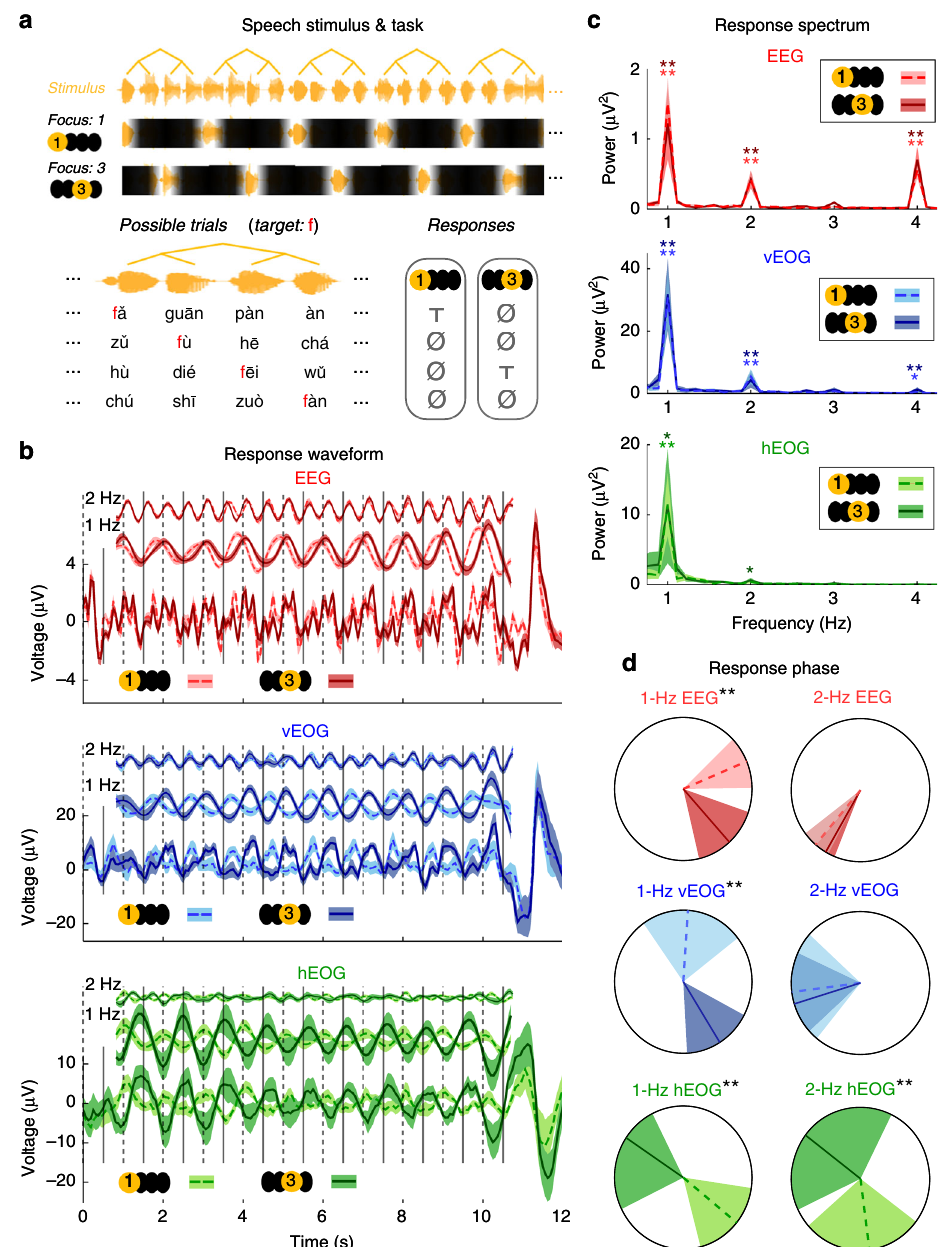
Fig. 3 Temporal attention modulates the phase of sentence-tracking EEG/EOG activity. a Stimulus and task. The stimulus is a sequence of four-syllable sentences (shown in orange). The listeners have to attend to the 1st syllable of every sentence in one condition and attend to the 3rd syllable instead in the other condition. Unattended syllables are shaded in the illustration. The target phoneme, e.g., /f/, appears once in every trial but it may appear as the 1st, 2nd, 3rd, or 4th syllable in a sentence with equal probability. The listeners respond by pressing a key only when the target phoneme appears in the syllables they attend to. In the illustration, T means that a target appears while Ø means that no target appears. The trial structure is described in more details in Supplementary Fig. 2. b Response waveform (0.5 – 4.5 Hz) and the waveforms fi ltered into 1-Hz wide bands centered at 1 and 2 Hz, respectively. The response near 1 Hz is strongly modulated by attention but the response near 2 Hz is not. The onset of the 1st syllable of each sentence is marked by a dashed vertical line while the 3rd syllable is marked by a solid line. The shaded areas in this panel and panel c cover 1 SEM across participants ( N = 15) on each side. The EEG signal is from channel Cz. c EEG and EOG response spectra. Spectral peaks at the sentential and phrasal rates are observed for EEG and EOG in both conditions. For each spectral peak, the P -value, mean, and SEM are shown in Supplementary Table 3. d The response phase extracted by the Fourier analysis. The shaded area covers the 95% con fi dence interval of the mean phase. If the phase difference between conditions is signi fi cant, stars are marked near the fi gure title. See text for the exact con fi dence interval. * P < 0.05; ** P <